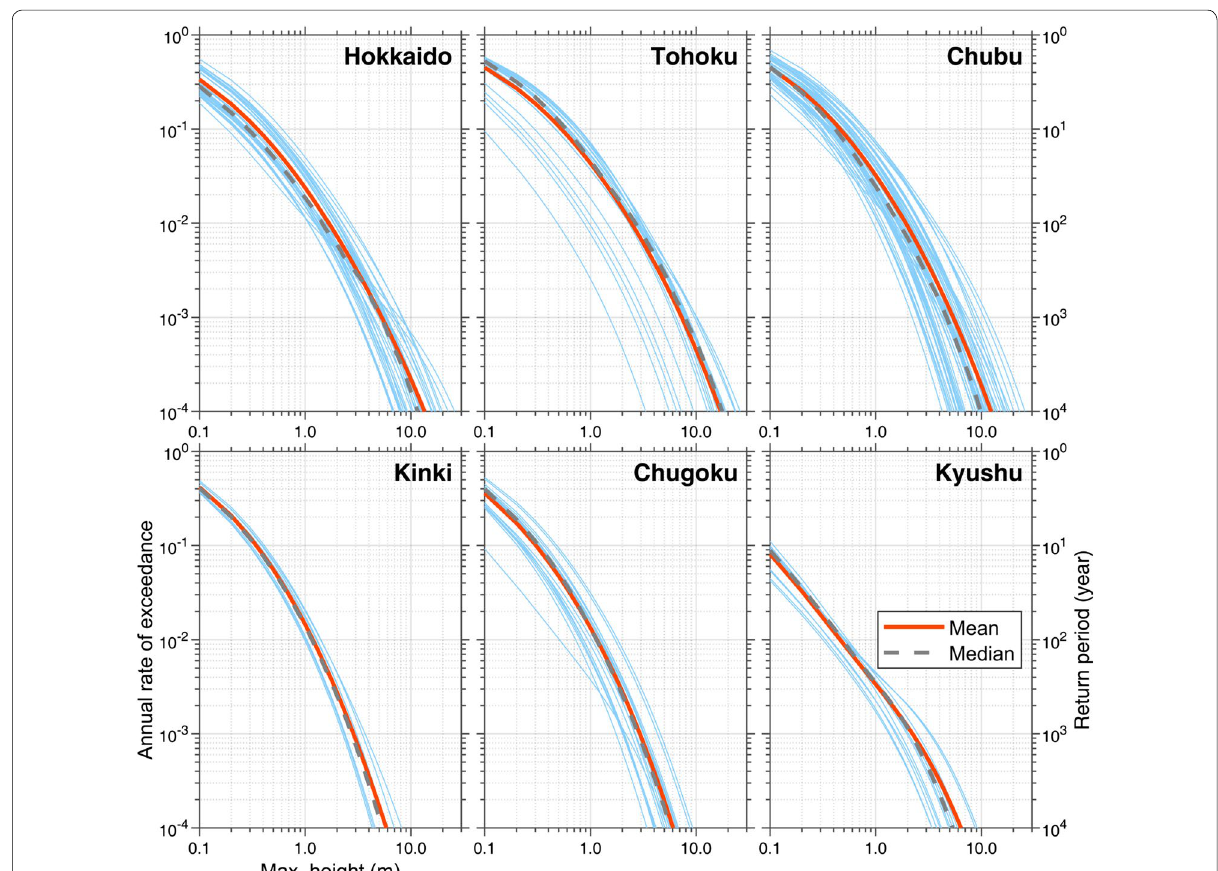
Fig. 7 Individual tsunami hazard curves at the specified coastal points (light blue) including mean and median curves over the respective region depicted in Fig.